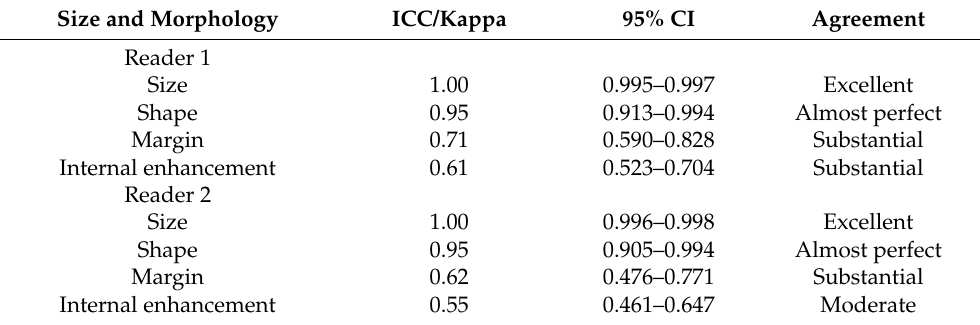
Table 3. Agreements in the size and morphology between ultrafast DCE-MRI and conventional DCE-MRI for Readers 1 and